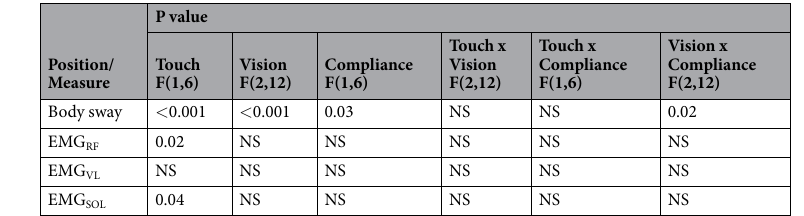
Table 1. Results from a GLM comparison of muscle activation and postural sway measures for quiet standing conditions in the antero-posterior direction. Body sway was measured at the level of the base of the neck (7 th cervicular vertebrae). NS: no significant difference. Three-way interactions were not studied due to the sample